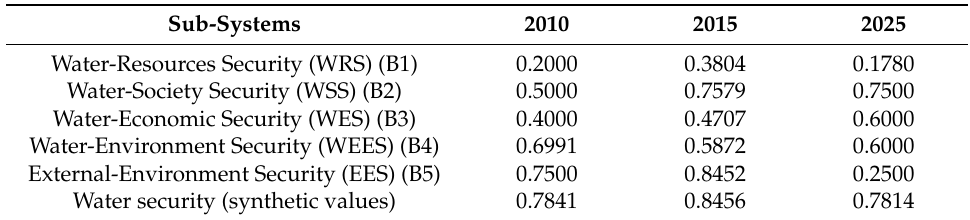
Table 4. Value of indicators at different